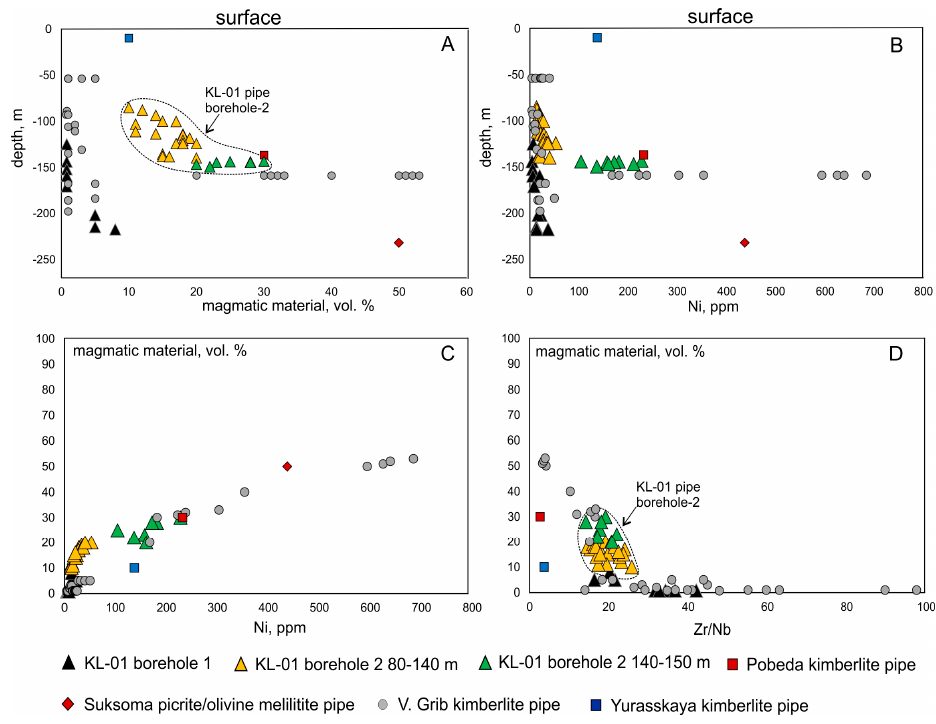
Figure 5. The correlations of depth of samples with volume % of magmatic material ( A ) and Ni content ( B ), and volume % of magmatic material with Ni content ( C ) and Zr/Nb ratio ( D ) in the ADP crater sandstones.